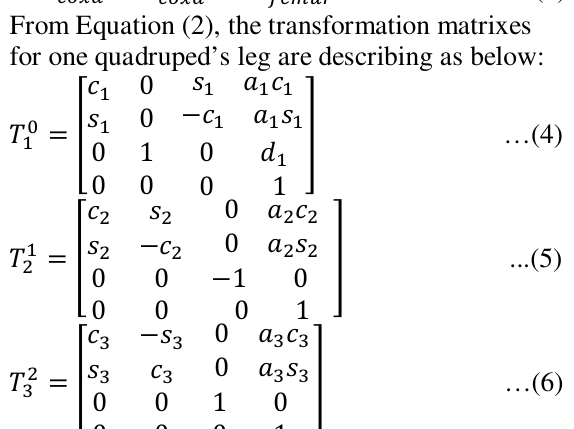
To find the inverse kinematics in each leg joint, the method simplifies this problem from 3D problem view into two 2D problem view, after that, using the geometrical analysis to solve and